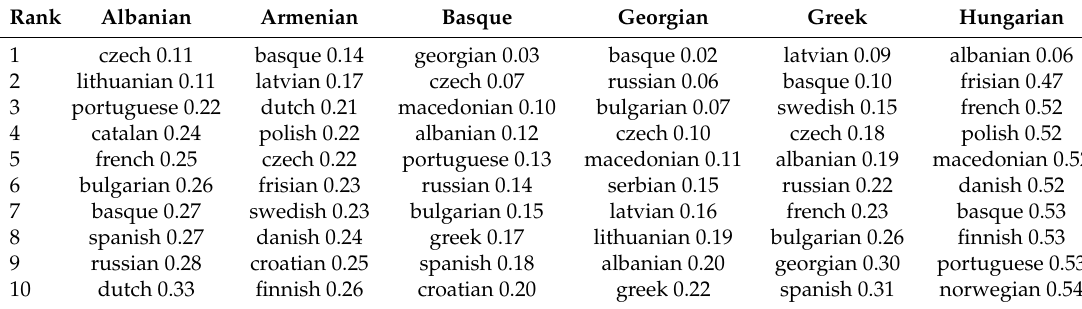
Table 2. Top 10 most similar languages to the six isolated targeted languages using ALD measure. To simplify, we just put the two first decimal places of ALD